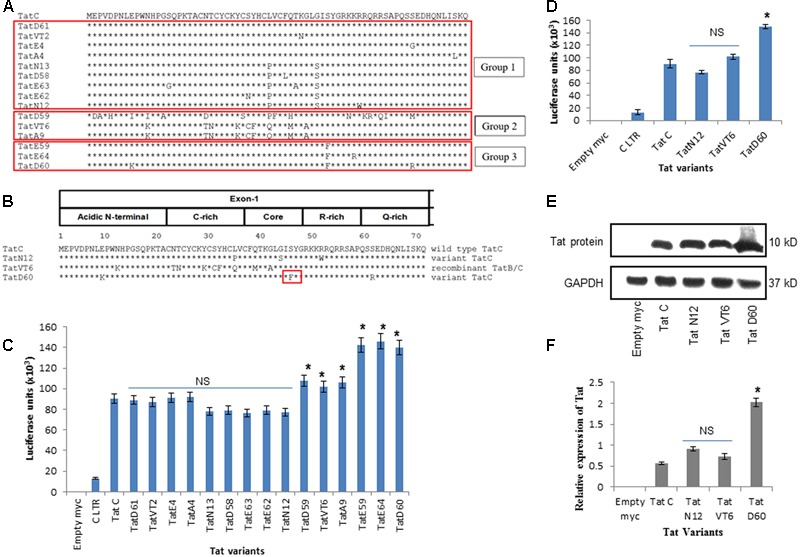
HIV-1 LTR transactivation by Tat variants. (A) Tat variants from HIV-1 infected individuals (n = 15) were aligned with wild-type Tat C (C.IN.93.93IN905). (B) Representative data of Tat variants[TatN12 (lack Ser46Phe) with Leu35Pro and Gly44Ser, TatVT6 (lack Ser46Phe) with B/C recombination and TatD60 (with Ser46Phe)] were aligned with wild-type Tat C. (C) HEK293 cells were co-transfected with pCMV-myc Tat variants and pGL3-Luc subtype C LTR. After 24 h of transfection, cells were harvested and lysed and luciferase activity was measured. The relative transactivation was expressed as mean luciferase units. Wild-type TatC was used as a reference Tat for comparison. Empty myc vector was used as a control. Subtype C LTR was used as a loading control. Luciferase activity of 15 Tat variants and wild-type Tat C normalized to empty pCMV-myc vector. (D) Luciferase activity of unique Tat variants and wild-type TatC normalized to empty pCMV-myc vector. Expression of Tat variants in HEK293 cells. HEK293 cells were transfected with pCMV-myc Tat variants and wild-type TatC. After 24 h, cells were harvested and immunoblotted with anti-myc antibody. The relative Tat protein expression was measured using ImageJ software. Wild-type TatC was used as a reference Tat for comparison. Empty myc vector was used as a control. GAPDH was used as a loading control. (E) Relative protein expression of Tat variants and wild-type TatC. (F) Quantification of Tat protein expression normalized to GAPDH. Error bar represents the standard deviation in triplicates. Statistical comparison of each Tat variant to Tat C was calculated by one-way ANOVA with the Tukey’s test (∗ denotes P < 0.05 and NS denotes not significant).